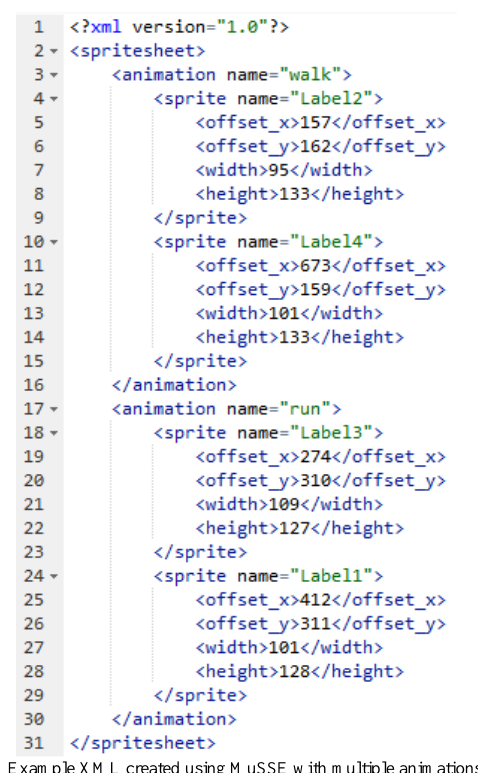
Fig. 16. Example XML created using MuSSE with multiple animations.